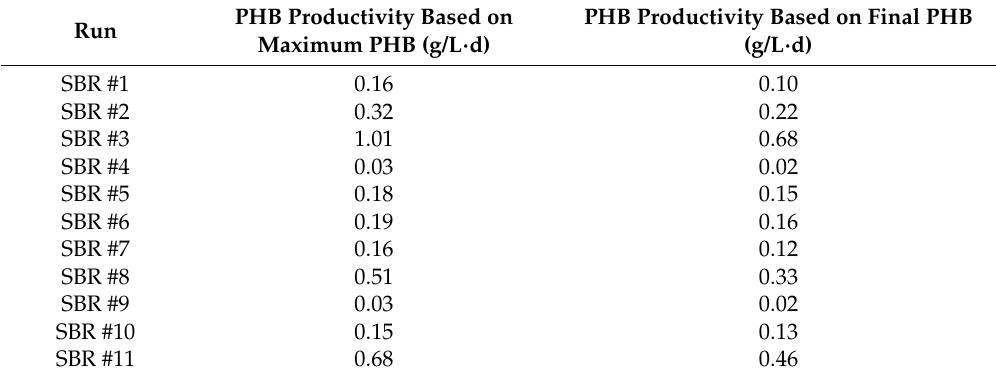
Table 3. PHB average productivity for the operation of